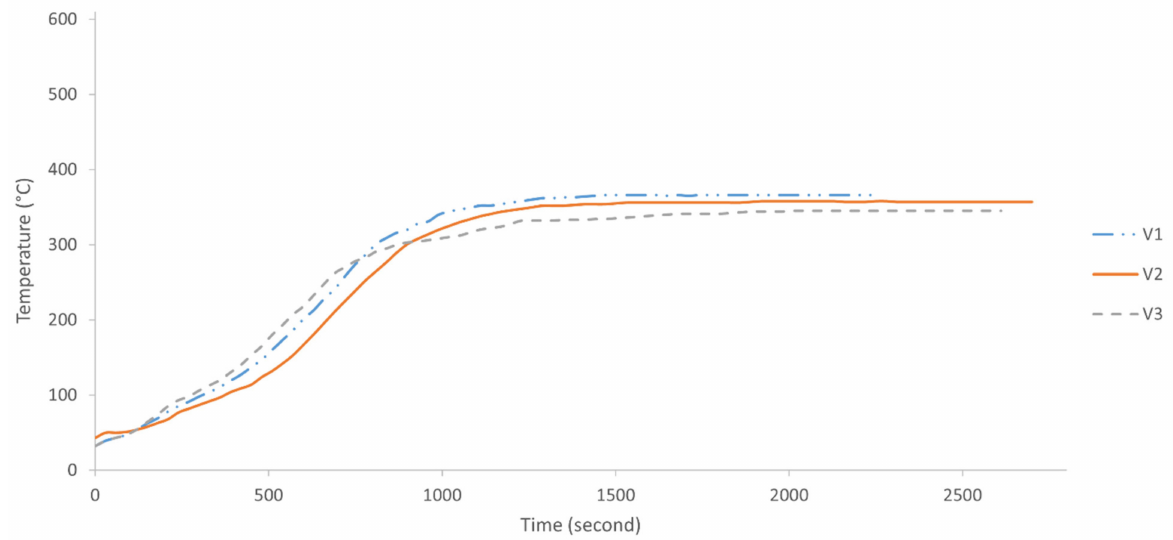
Figure 11. Graph temperature versus time of validated samples in fire-retardant test.